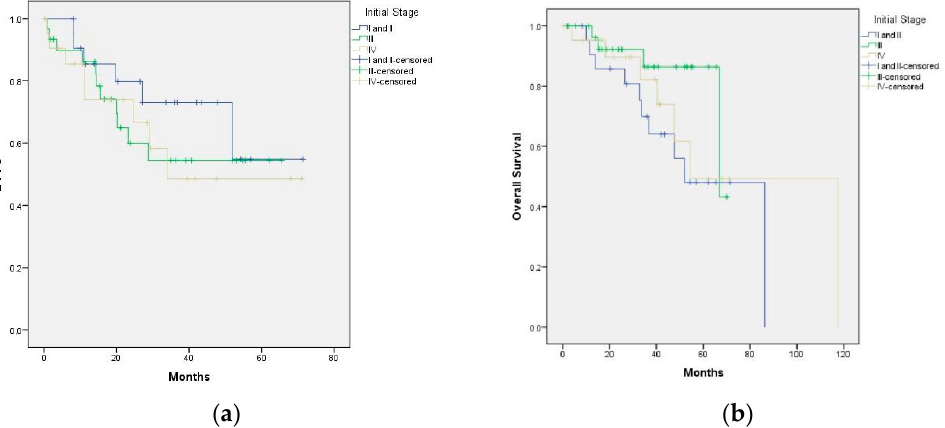
Figure A3. ( a ) Impact of initial stage and treatment on local control ( p = 0. 62); ( b ) impact of initial stage and treatment on overall survival ( p = 0.201).